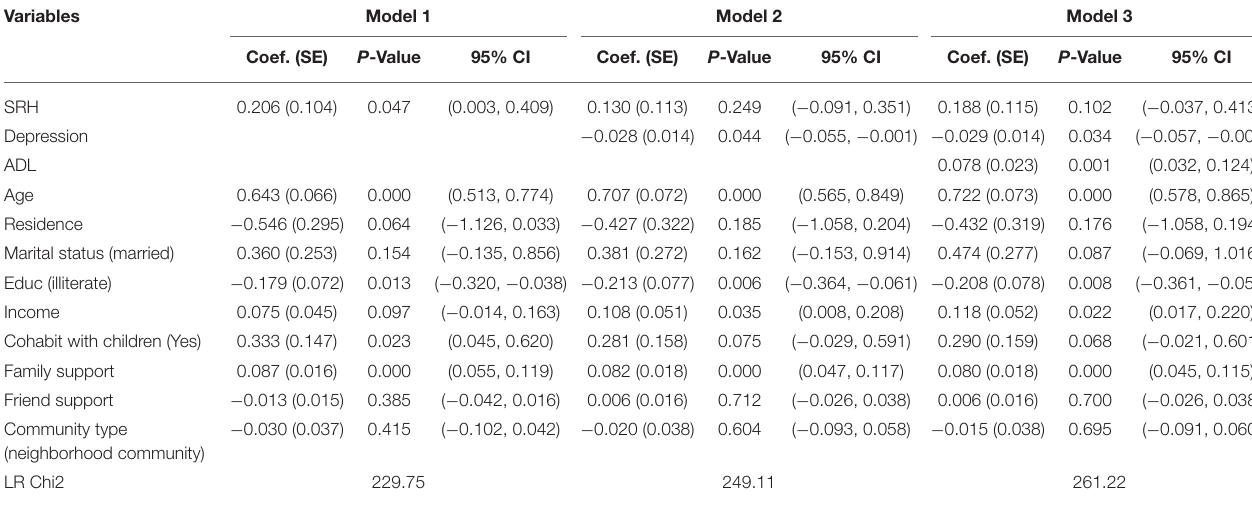
TABLE 2 | The effect of health changes on community health screening